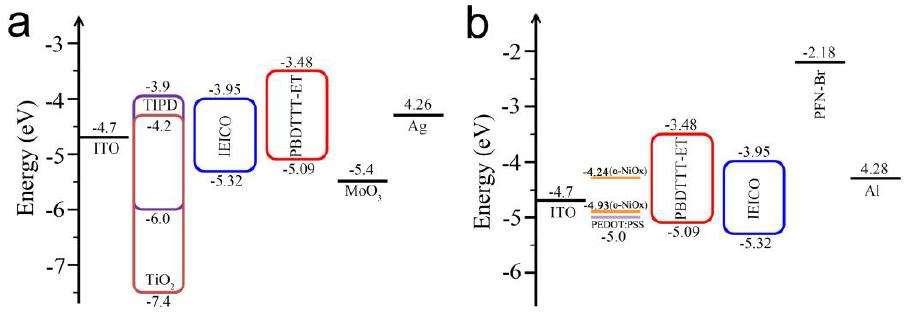
Figure 2. Energy level diagrams of ( a ) inverted and ( b ) conventional OSCs.